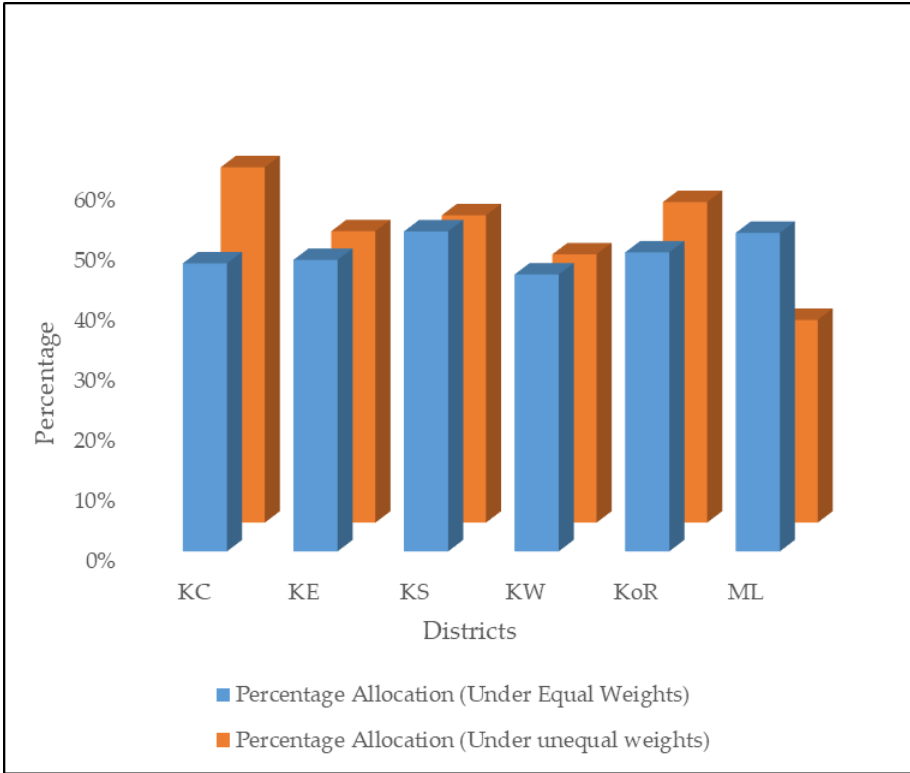
Figure 3. Water allocation under homogenous and heterogenous weights (scenario 3).